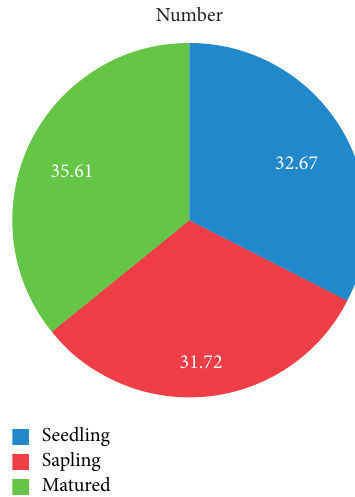
Figure 7: Density distribution percentage of seedling, sapling, and matured woody plant species in Kenech forest.